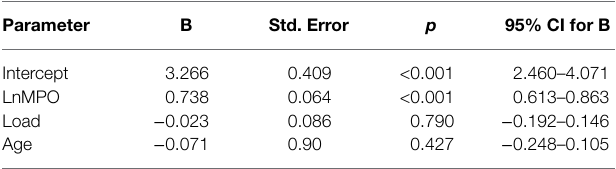
TABLE 4 | Parameter estimates and 95% CIs for the dependent variable, LnVO 2 , during the repeated sprint protocol when mean power output (MPO) was used as covariate. B Std. Error 95% CI for B